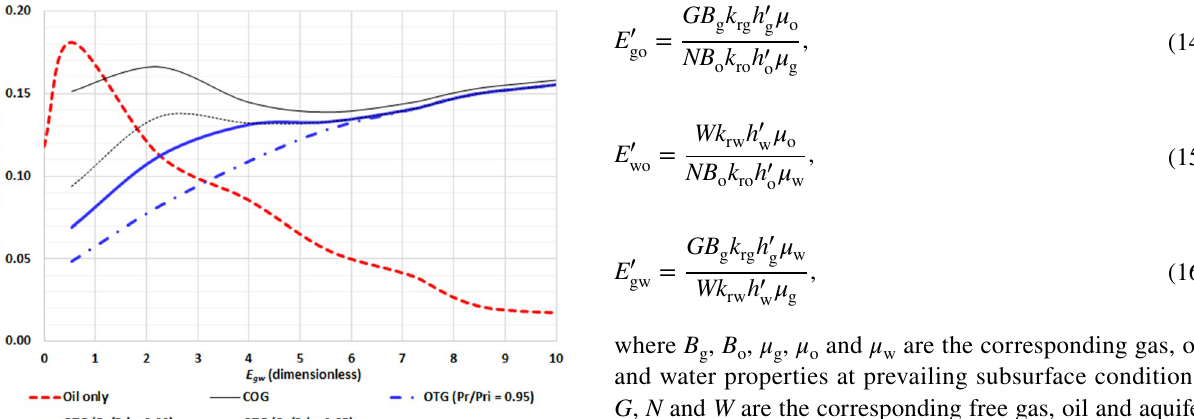
gw (10% discount rate) with hori-